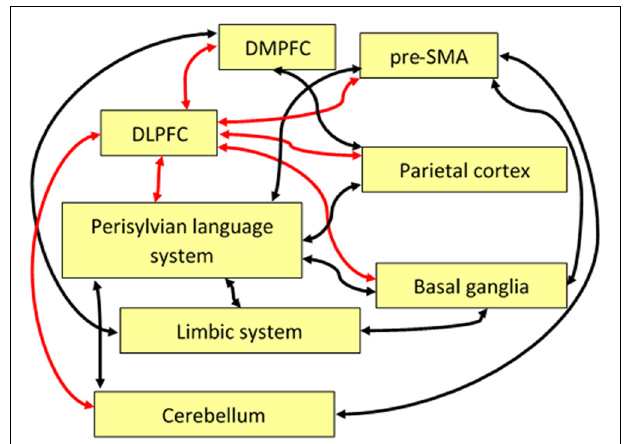
FIGURE 2 | Schematic display of some functional pathways linking the DLPFC directly or indirectly to the language system. Red arrows indicate the central role of the DLPFC with regard to executive control, and black arrows show pathways important for language and speech processing that are indirectly connected to the DLPFC. Note that some of these pathways, anatomically, may comprise relay stations that are not shown here such as, for example, the thalamus. Abbreviations: SMA, supplementary motor area; DLPFC, dorsolateral prefrontal cortex; DMPFC, dorsomedial prefrontal